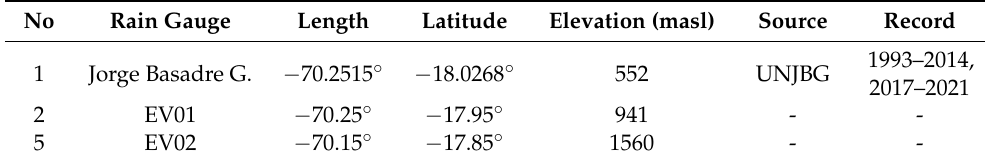
Table 2. Virtual rain gauges and JORGE BASADRE rain gauge.